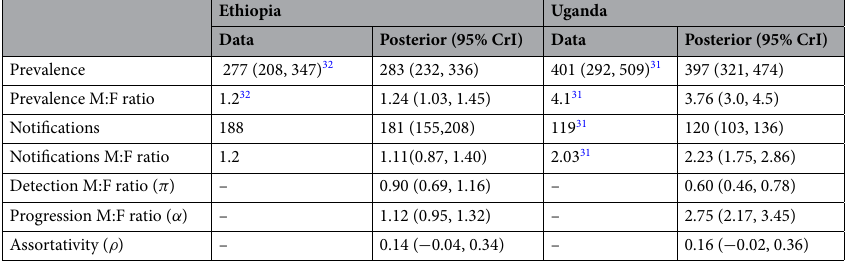
Table 2. Posterior estimates for exemplar settings: calibration targets compared to data, and parameters determining sex difference for